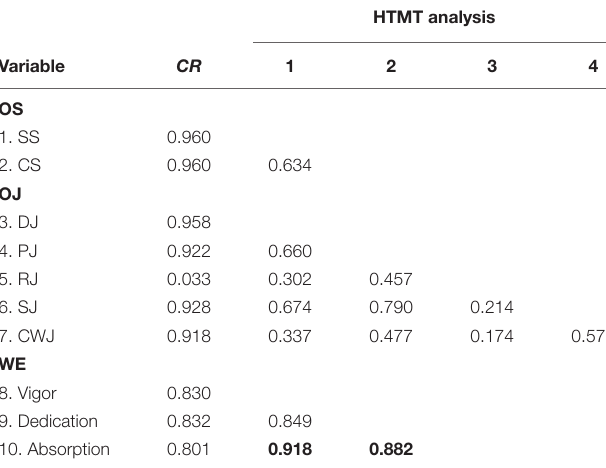
TABLE 6 | CR and HTMT analysis for study variables.